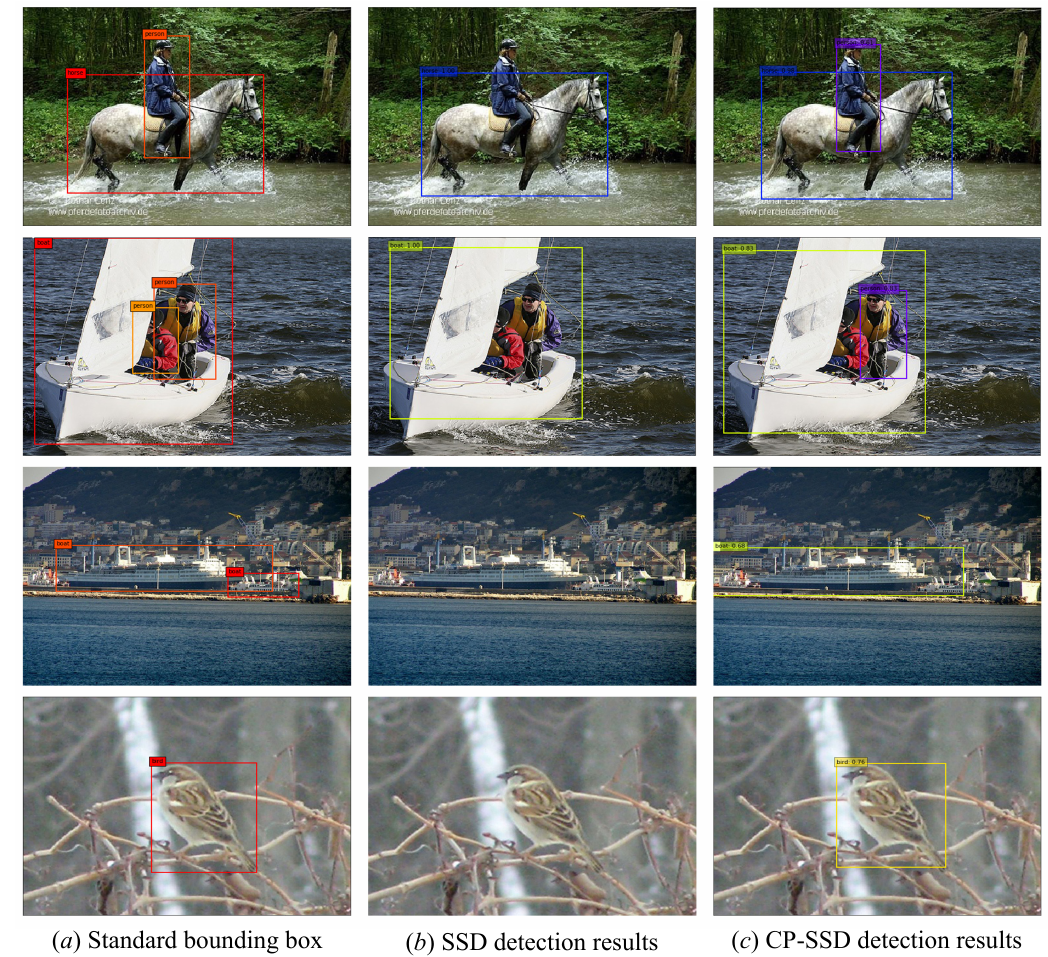
Figure 5. Partial detection